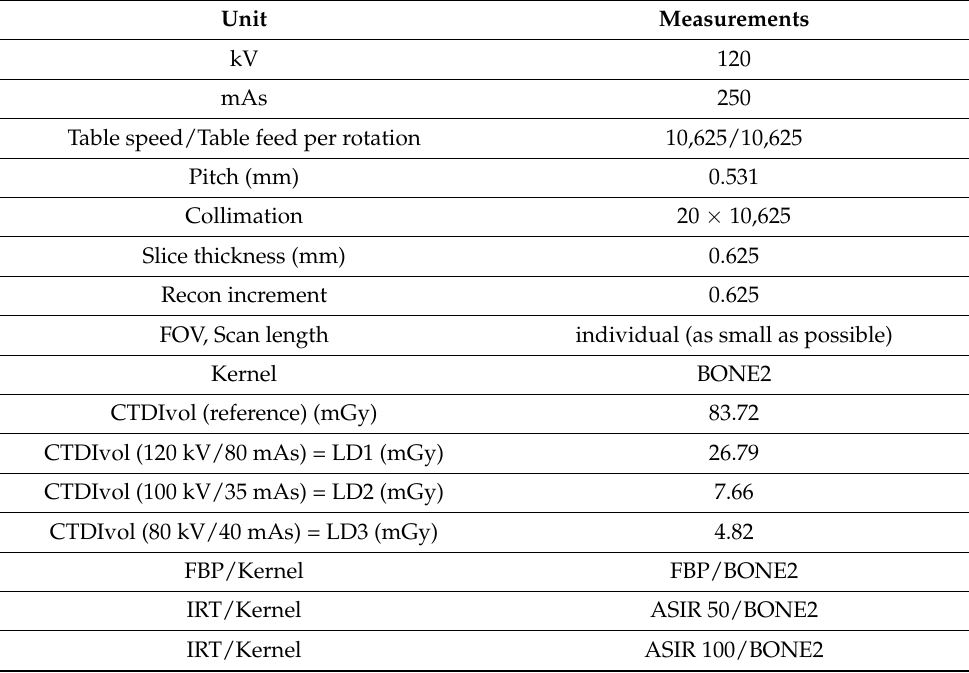
Table 1. Technical data of the multi-slice CT protocols.